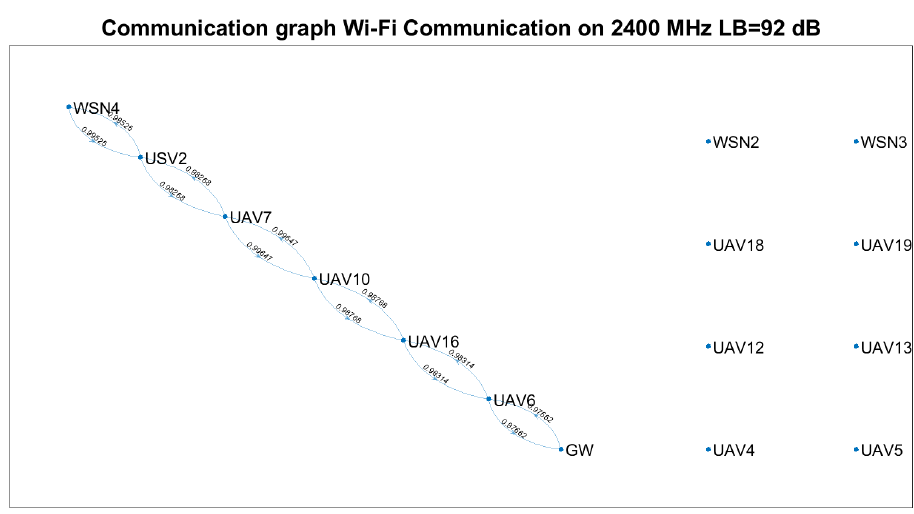
Figure 12. Algorithm evaluation: Communication chain and corresponding weights. δ d = 20 m, δ h = 7 m, ρ = 0.2 LB = 92 dB, d = 2.393, n vn =